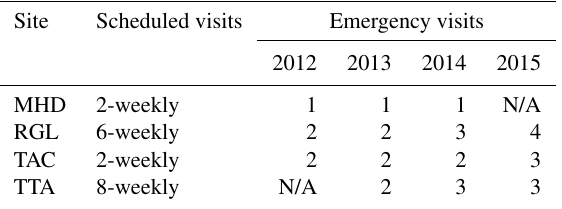
Table 5. Maintenance schedule for all UK DECC sites from January 2012 to September 2015. N/A: no emergency site visits were